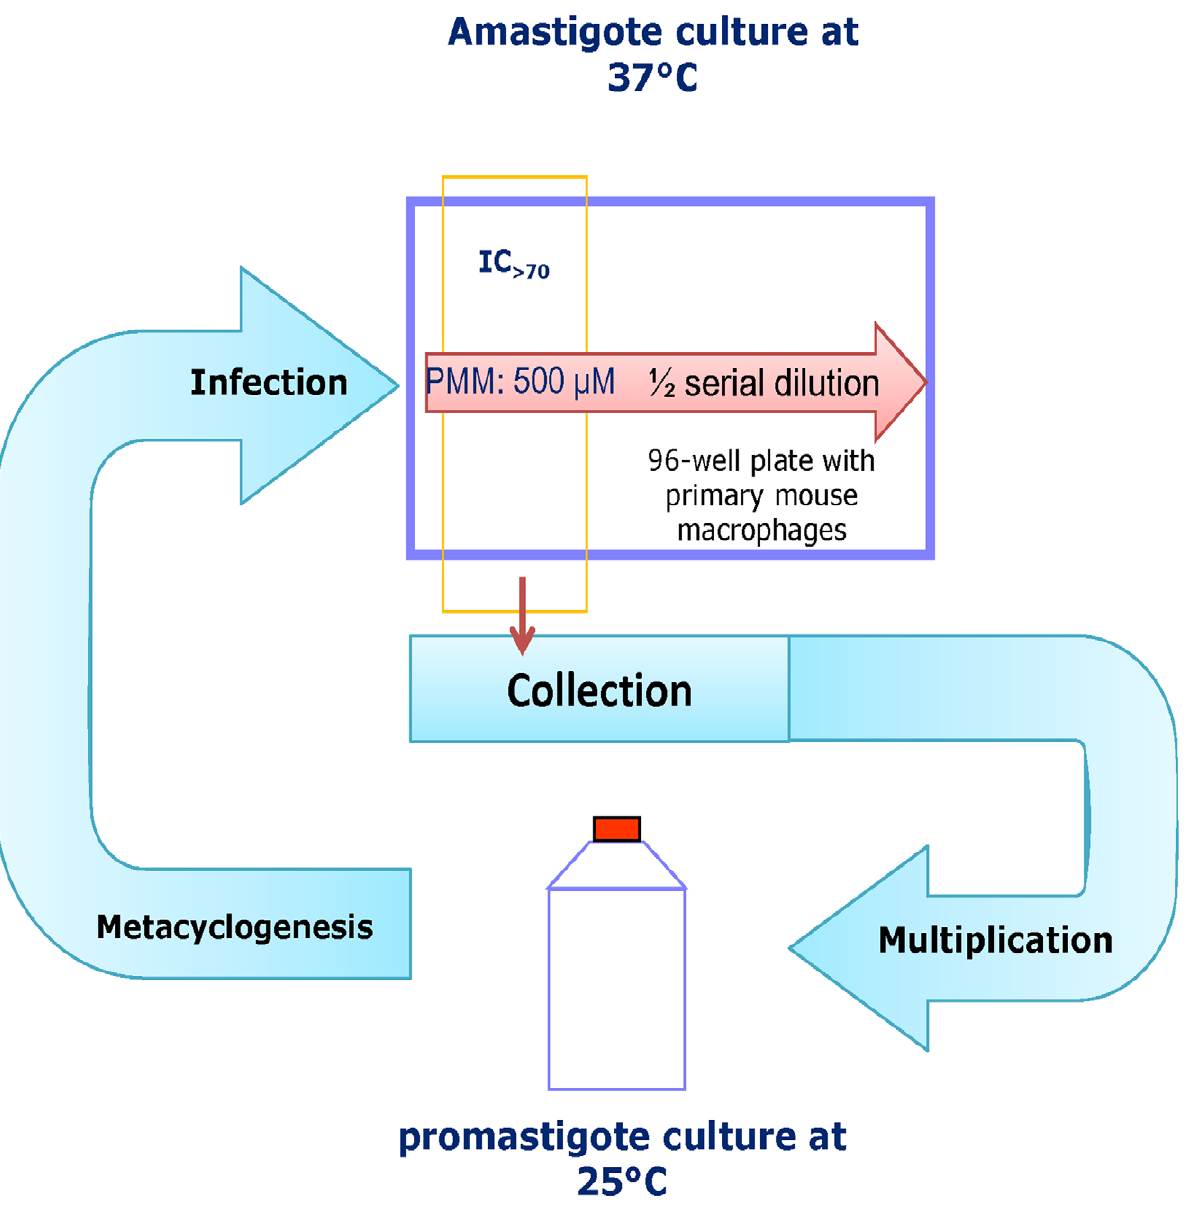
Figure 1. Selection procedure for induction of PMM-resistance using intracellular L.donovani amastigotes. Late stationary-phase promastigotes were used to infect primary mouse macrophages exposed to 2-fold PMM dilutions starting from 500 m M. After 5 days, surviving intracellular amastigotes at the highest PMM concentration (checked after Giemsa staining on a duplicate plate) were allowed to transform back into promastigotes by replacing the RPMI cell culture medium by MEM-based promastigote medium and incubation at room temperature for 1 week. Next, the recovered promastigotes were expanded in 25 ml tissue culture bottles without PMM pressure and used to infect a new batch of primary mouse macrophages for another cycle of